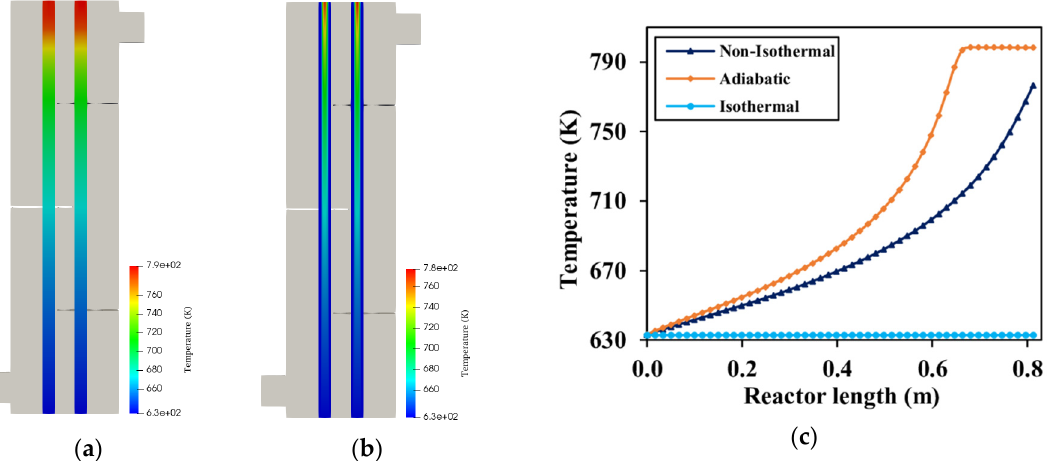
Figure 10. Temperature contour and profiles of a multi-tubular reactor under different thermal conditions: ( a ) temperature contour under adiabatic conditions; ( b ) temperature contour non-isothermal conditions ( c ) temperature profiles under isothermal, non-isothermal, and adiabatic conditions.